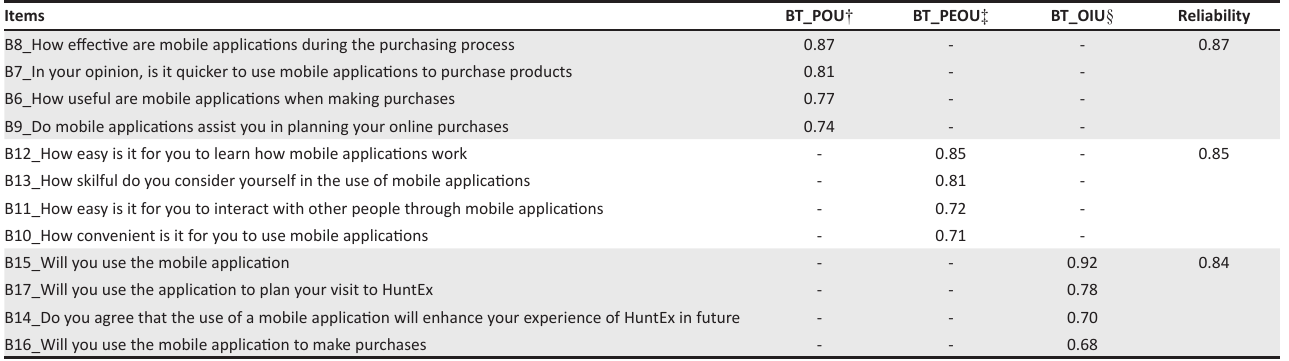
TABLE 2: Factor matrix for business event tourists’ perceived usefulness of technology, business event tourists’ perceived ease of use of online technology and business event tourist’s intention to use online technology.